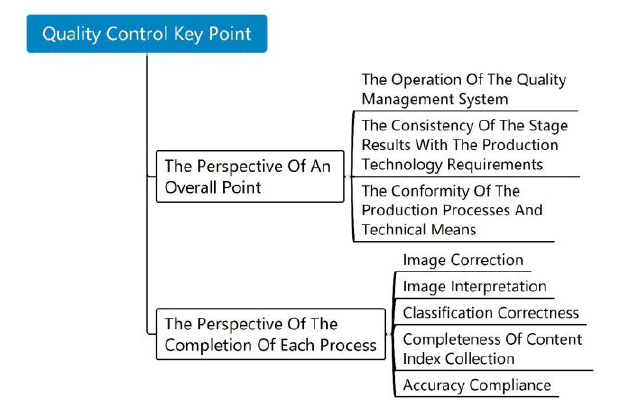
Figure 1 . Quality control key points.